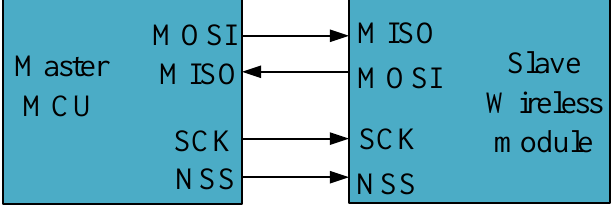
Figure 7. Communication method between the master device and the slave device.